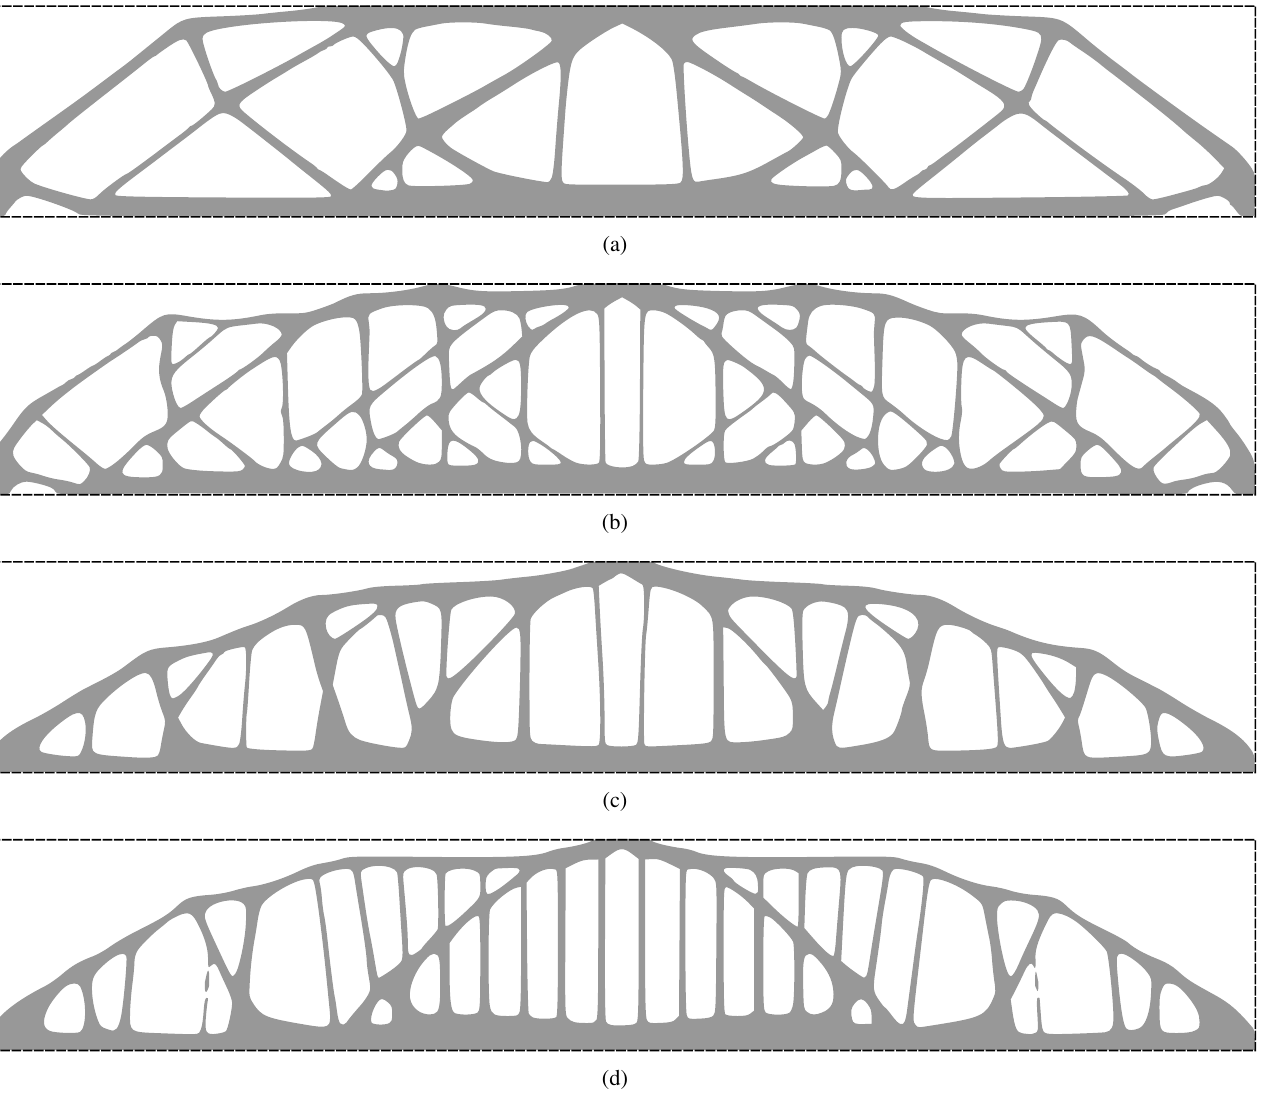
Fig. 8 Optimized shapes for the two-dimensional MBB Beam example of Section 5.4, solving Problem (29) with the upper-weight manufacturing compliance P uw ( Ω ) and parameters (a) α c = 0 . 30 , (b) α c = 0 . 10 , (c) α c = 0 . 05 , and (d) α c = 0 . 03